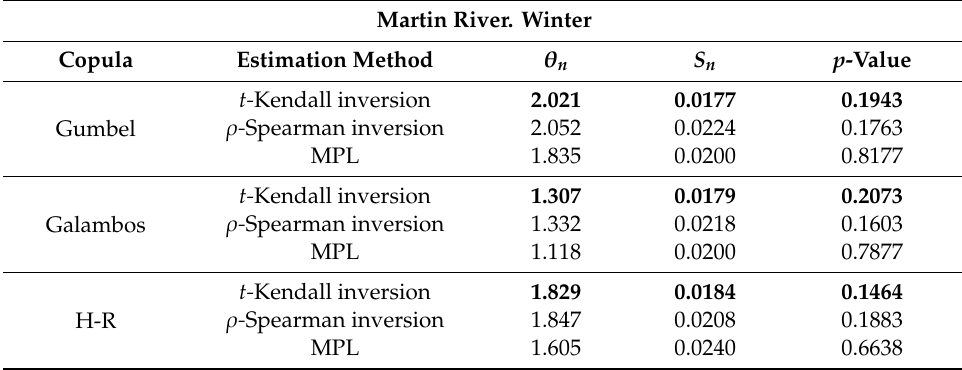
Table 7. Estimated copula values for di ff erent methods. Winter station.